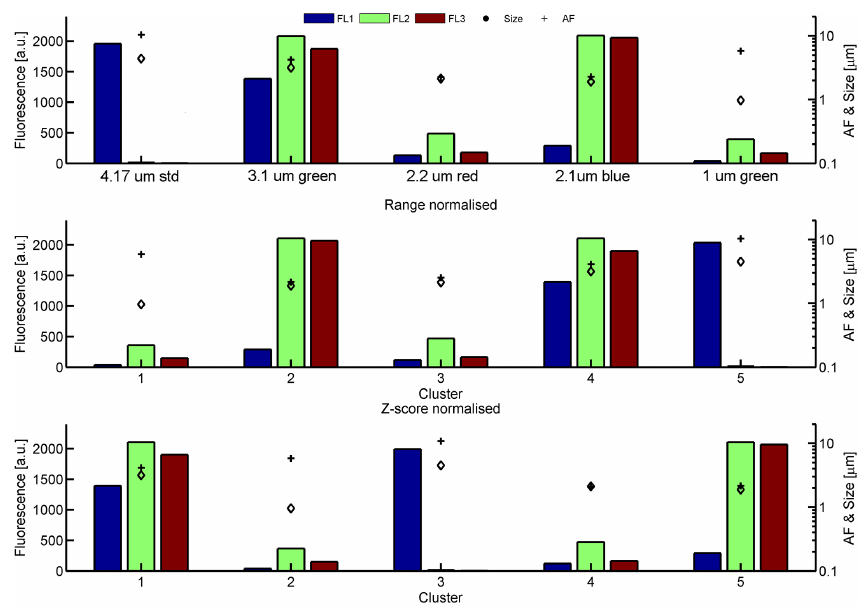
Figure 2. Top panel: average FL1–3 detector intensites (blue, green and brown bars, left axis), size (diamond, right axis) and asymmetry factor (cross, right axis) for the five PSL samples. Middle and bottom panels: the same as for the top panel but for the Ward linkage solution centroids using range (middle) and z -score (bottom) normalisation.